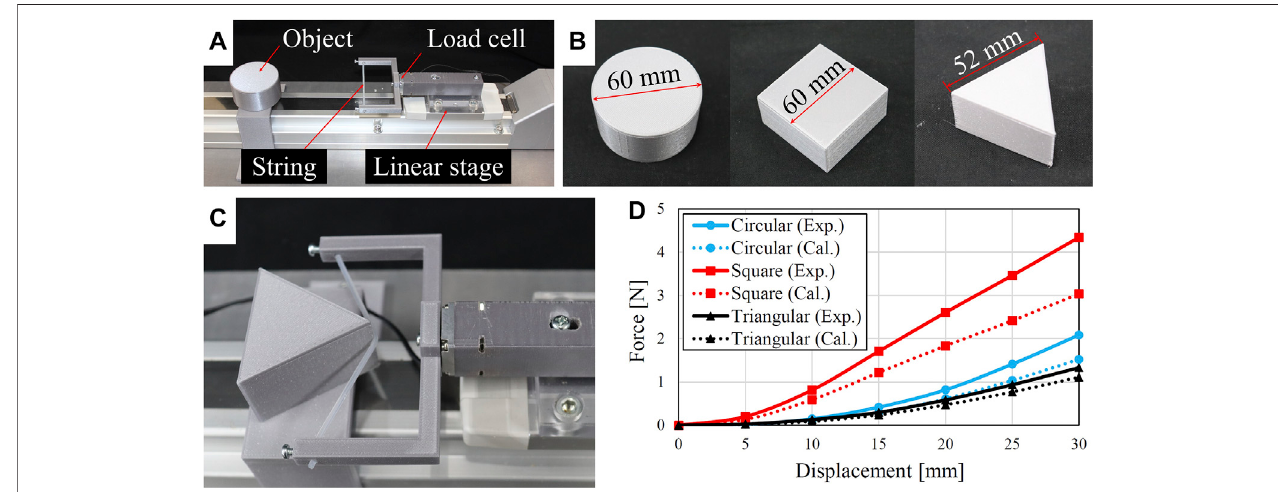
FIGURE 8 | Bending force tests: (A) experimental setup, (B) three objects for the tests, (C) test scenario on the triangular shaped object, and (D) comparisons of binding force between experiments and calculations.